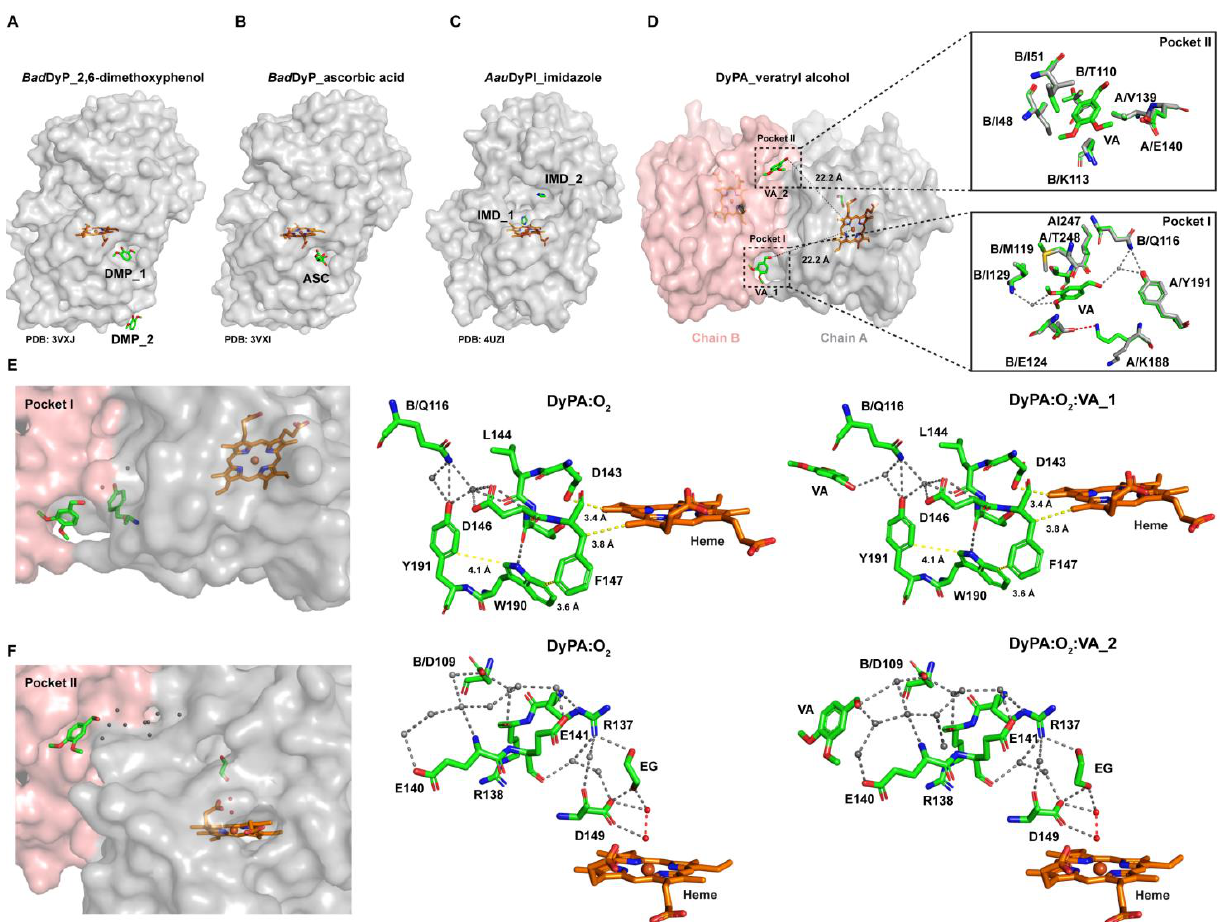
Figure 8. Overview of veratryl alcohol binding sites on Dictyostelium DyPA and comparison of substrate binding by other DyPs. ( A ) DMP binding sites in Bad DyP:DMP (PDB: 3VXJ) complex structure. ( B ) Ascorbic acid binding site in Bad DyP:ASC (PDB: 3VXI) complex structure. ( C ) Imidazole binding sites in Aau DyPI:IMD (PDB: 4UZI) complex structure. ( D ) Veratryl alcohol binding sites in Dictyostelium DyPA:O 2 :VA complex structure. The distance between the iron atom of heme moiety and the oxygen atom of the veratryl alcohol hydroxyl group is indicated by a dashed line. The lower inset shows a superimposition of substrate-free and veratryl alcohol-bound Dictyostelium DyPA structures for binding site I, while the upper inset shows binding site II. Carbon atoms in the substrate-free structure are represented in white and carbon atoms in the Dictyostelium DyPA:O 2 :VA complex are shown in green. ( E , F ) Proposed long-range electron transfer pathways from veratryl alcohol binding sites I and II to the heme moiety of Dictyostelium DyPA. Position of the Dictyostelium DyPA veratryl alcohol binding site I/II relative to the heme cofactor. The atoms of the activated oxygen molecules, with elongated bond distances between the oxygen atoms of 1.7 and 2.0 Å in the two monomers, are colored in red and water molecules are shown as grey spheres. Hydrogen bonds are represented as grey dashed